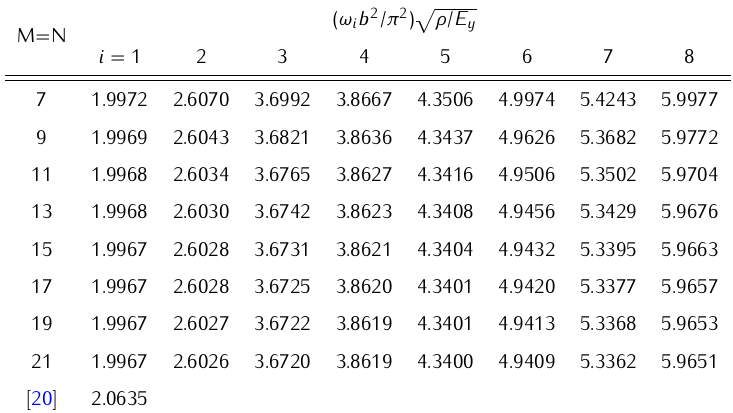
15 ◦ / − 15 ◦ / 15 ◦ ) with edges elastically restrained against rotation and